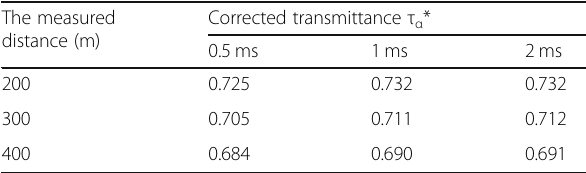
The measured distance